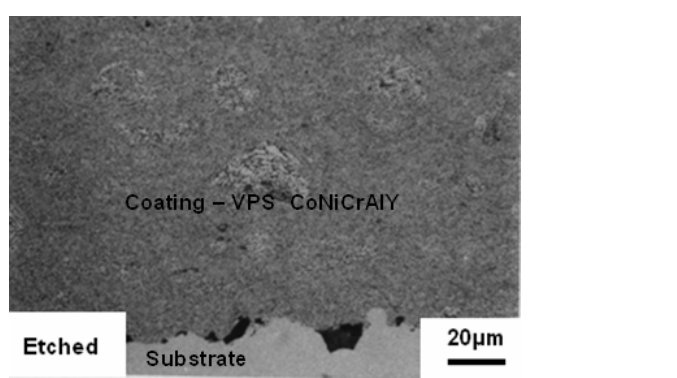
Figure 9 – Etched microstructure of the Co32Ni21Cr8Al0.5Y coating deposited on the sample with a substrate distance of 270mm (higher magnification) Slika 9 – Nagrizena mikrostruktura Co32Ni21Cr8Al0.5 Y prevlake deponovane na uzorku sa odstojanjem substrata 270mm (više uve ć anje)